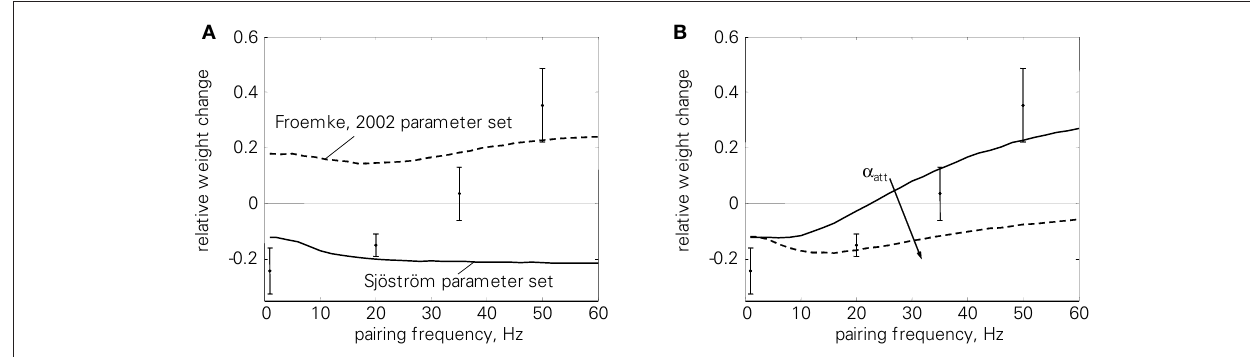
= 0, α = 0.8), using att att